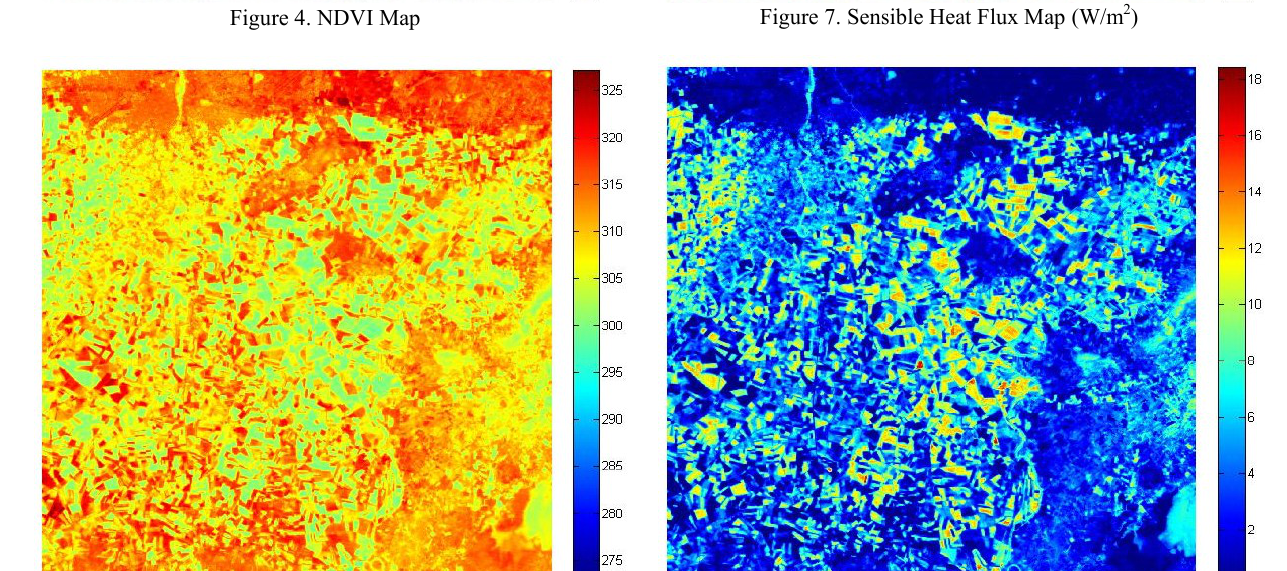
Figure 8. Daily Actual Evapotranspiration Map